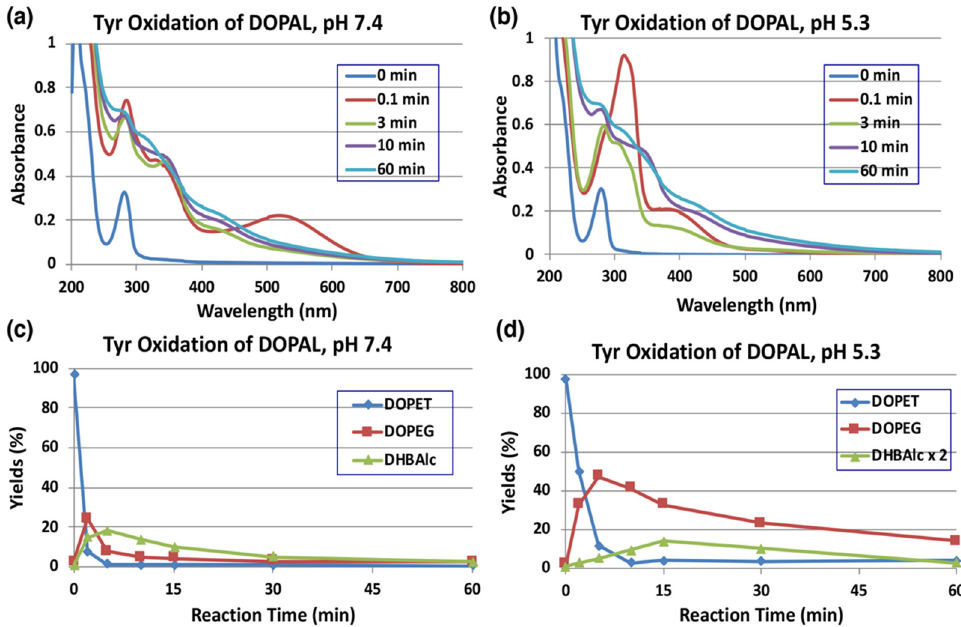
Figure 2. Time course of the tyrosinase-catalyzed oxidation of DOPAL (100 µM) and HPLC analysis of reaction products. ( a ) UV/visible spectral changes of DOPAL at pH 7.4 and 25 °C. ( b ) At pH 5.3 and 25 °C. ( c ) HPLC analysis following the tyrosinase-catalyzed oxidation of DOPAL at pH 7.4 and 37 °C and ( d ) at pH 5.3 and 37 °C. Reaction was stopped by the addition of NaBH 4 followed by 0.8 M HClO4. Data for the spectral changes were obtained from single experiments, but reproducibility was confirmed for each experiment ( a , b ). Data for the HPLC analysis were obtained from averages of two independent experiments ( c , d ).